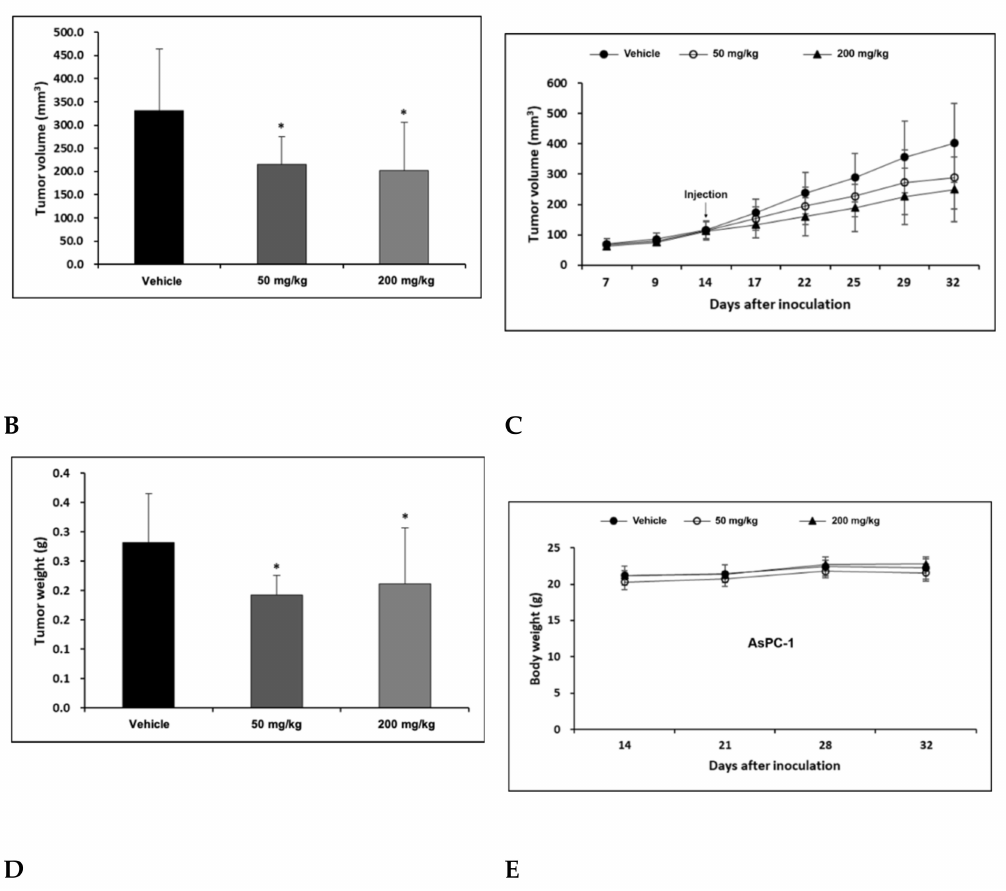
Figure 4. Suppression of tumor growth by H-REV107 peptide in mice inoculated with pancreatic AsPC-1 cancer cells. AsPC-1 cells were inoculated on the skin in a xenograft mouse model and injected the H-REV107 peptide into the abdominal cavity on a daily basis. ( A ) Photograph of tumor treated with the indicated dose of H-REV107 is shown. ( B – C ) Volume and weight of tumor were measured. Data are presented as means ± SD. Statistic tests were performed using Student’s t -test and Dunnett’s test. The minimum level of statistical significance was set at a p -value of 0.05 for all the analyses. ( D , E ) Body weight of each mouse was measured daily during injection of H-REV107